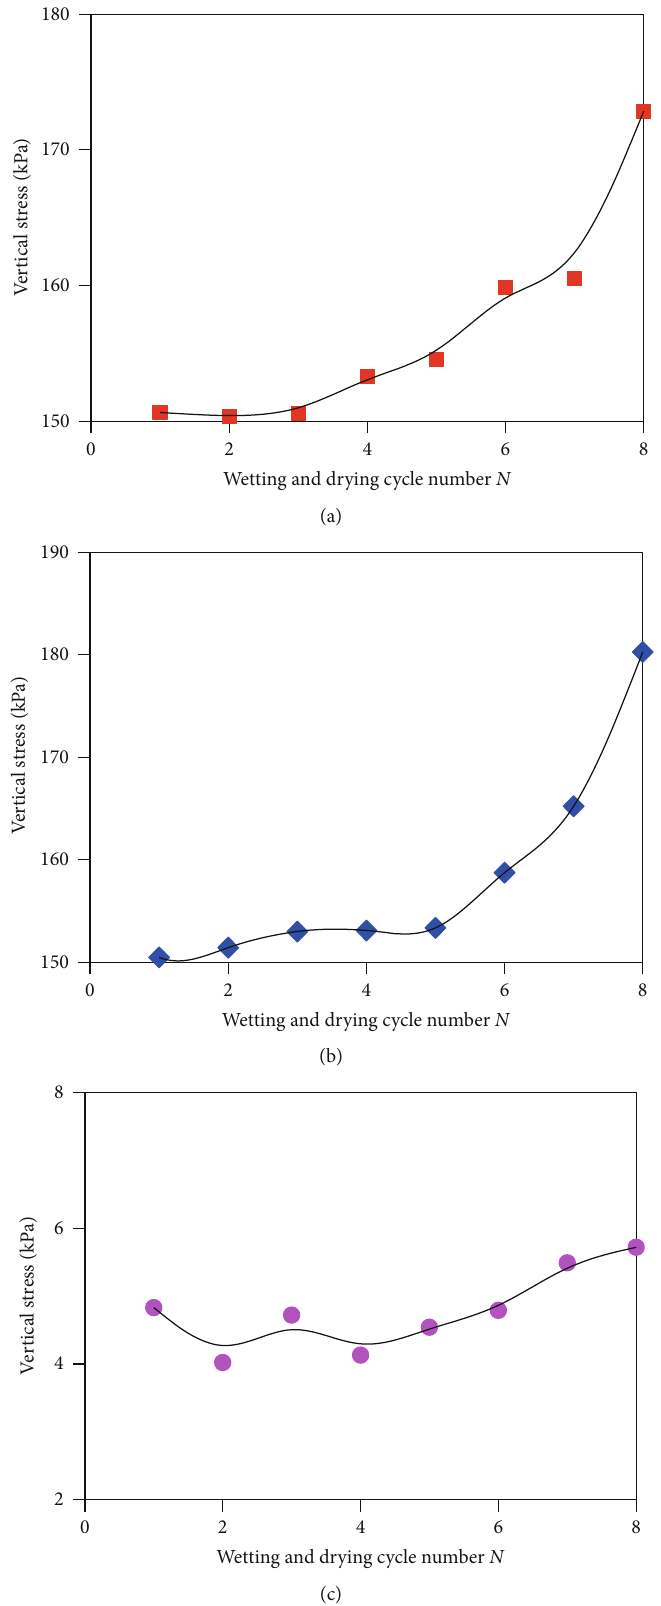
Figure 7: In fl uence of wetting-drying cycle number on vertical stress of the tunnel surrounding rock: (a) left wall, (b) right wall, and (c)